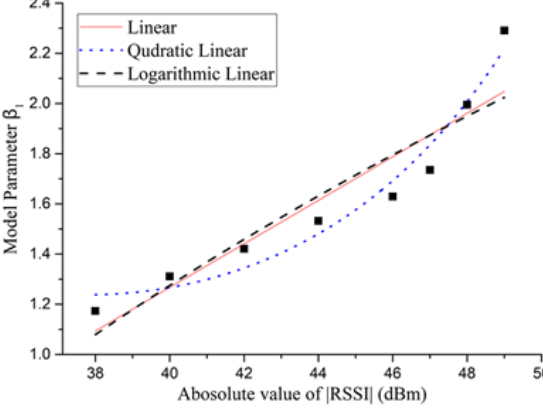
Figure 5. | RSSI | vs. energy model parameter β 1 .